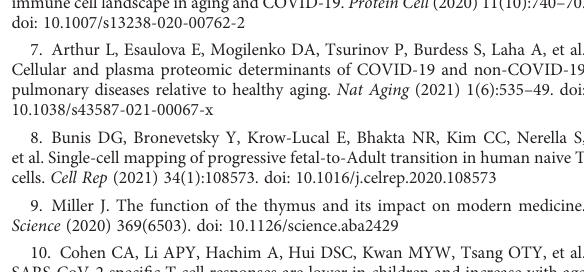
SUPPLEMENTARY FIGURE 9 Active intercellular crosstalk of myeloid cells in childhood. The intercellular crosstalk number of each subtype of monocyte cells estimated using Cellphone DB, including CD14 + monocyte 1, CD14 + monocyte 2, CD14 + monocyte 3, CD14 + monocyte 4 and CD16 + monocyte. SUPPLEMENTARY FIGURE 10 Characterization of CD3 + unde fi ned T cells. (A) Boxplots of the percentage of CD3 + unde fi ned T subtype in PBMCs. (B) The volcano map showed the DEGs in CD3 + unde fi ned T of the G1 vs G3 groups. (C) Expression of canonical marker genes of T cells and B cells in CD3 + unde fi ned T. (D) The results of transcription factor analysis for CD3